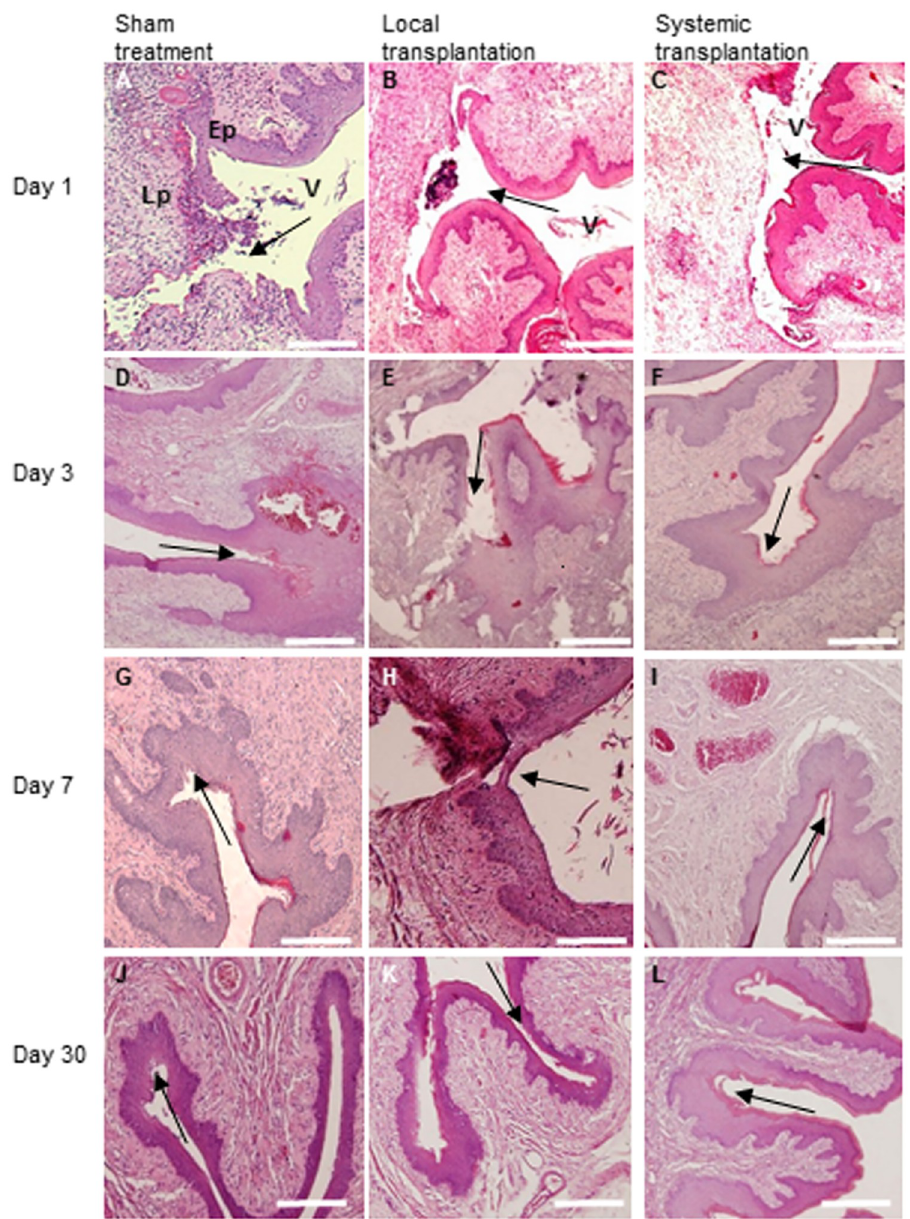
Fig 1. Healing of vaginal incision in sham, local and systemically transplanted rats. On day one post injury, disruption of the epithelial layer and the adjacent lamina propria was noted in all groups (A-C). On day three post injury, the epithelial cut was bridged but the layer was still thick in the sham (D) and I.V. (F) groups while it was disrupted in the local group (E). On day seven post injury, in the sham (G) and I.V. (I) treated rats the epithelial layer had a normal appearance while there was still partial epithelial disruption and disorganization of the sub-epithelial fibromuscular tissue in local transplanted rats (H). Complete re-epithelization was observed on day 30 in the sham (J), local (K), and I.V. (L) treated rats. n = 5 rats in each treatment group at each time point. The location of the incision is marked with the black arrow. Abbreviation: V = vagina; Ep = epithelium; Lp = lamina propria; Scale bar = 200 μ m.